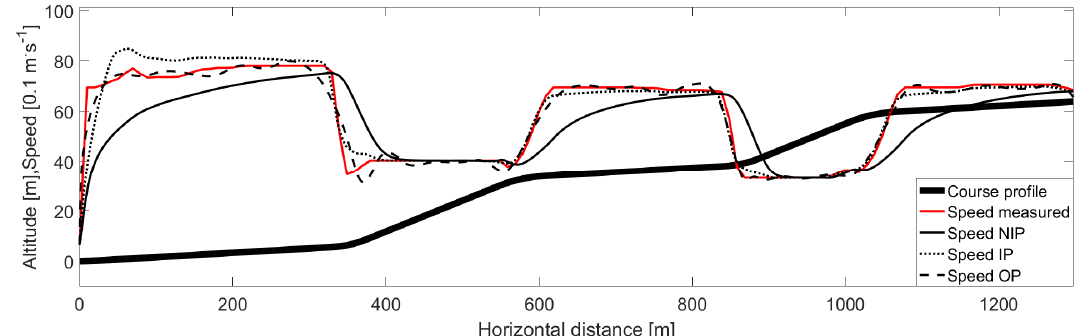
Figure 1. The sprint time-trial course profile and speed profiles of the measured treadmill speed and the simulated speed of the various power estimates: Non-inertial power estimate (NIP), inertial power estimate (IP), and optimization power estimate